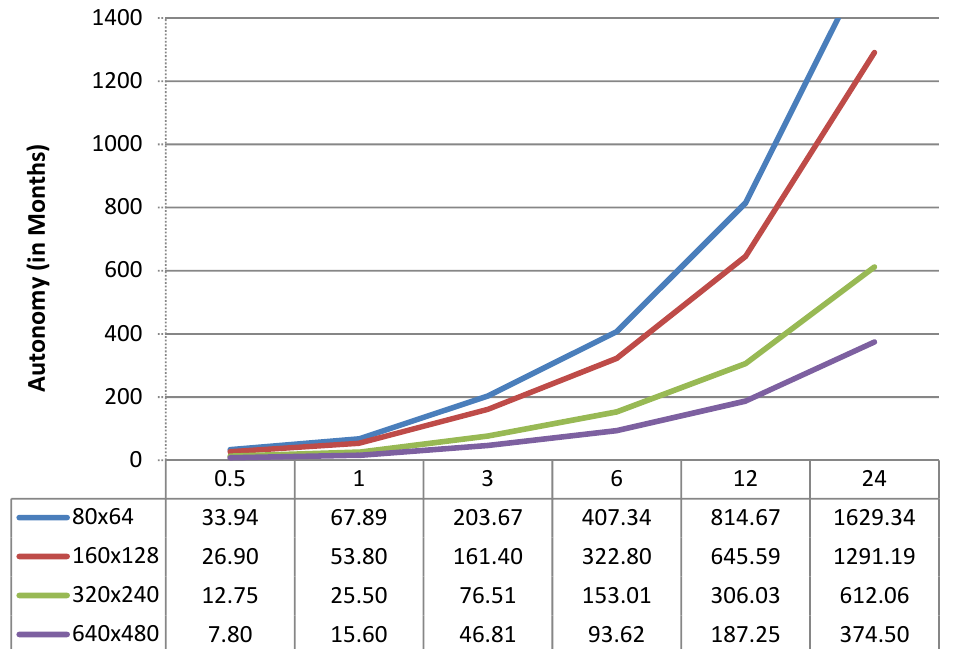
Figure 7. Autonomy of our image sensor equipped with 1,200 mAh battery (80% efficiency) with different image format sizes and capture